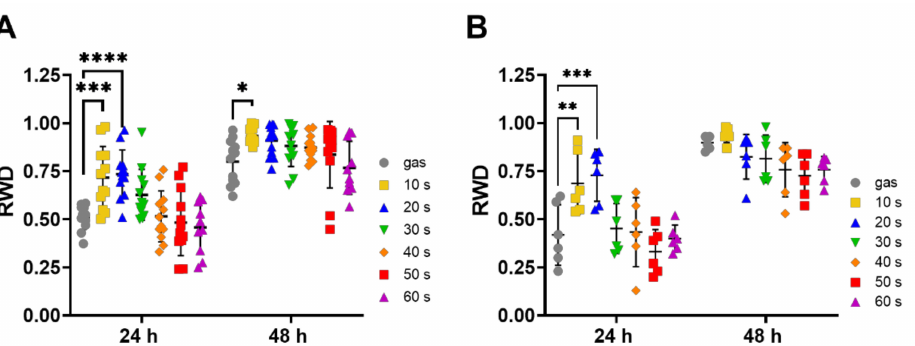
Figure 4. Short term CAP treatments of human primary keratinocytes stimulated their migration. Scratches were made manually on a completely confluent monolayer of primary human keratinocytes pre-treated for 3 h ( B ) or not ( A ) with 10 µ g/mL mitomycin, and cells were exposed to CAP for 10 to 60 s, as indicated. The plate wells were monitored by bright-field microscopy 24 h and 48 h after plasma treatments, and quantitative analyses of the scratch closing, expressed as relative wound density (RWD), were performed. Treatments with gas alone for 60 s were used as control. The results corresponded to experiments performed with keratinocytes from 3 different donors; n = 6, error bars represent S.D.; *, p < 0.05; **, p < 0.005; ***, p < 0.001; ****, p < 0.0001; ns: not